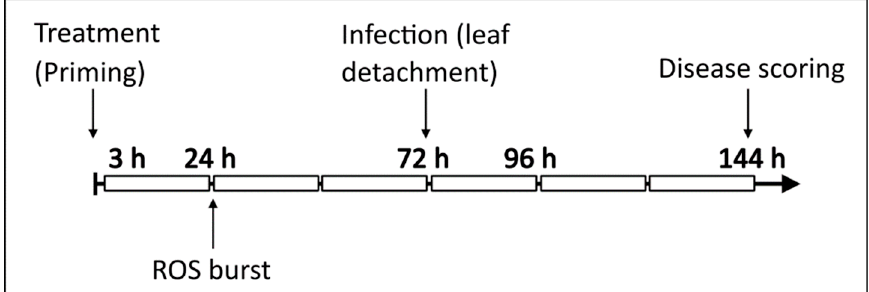
Figure 5. Schematic representation of the experimental setup of priming, infection and sampling of material. Plants were treated with fructans at 0 h. Seventy-two hours after treatments, leaves detached and infected with B. cinerea . Samples were taken 3 h, 24 h and 72 h after treatment, and 24 h after infection (96 h after treatment). Disease symptoms were scored 72 h after infection (144 h after treatment). ROS burst experiments were conducted 24 h after treatments.